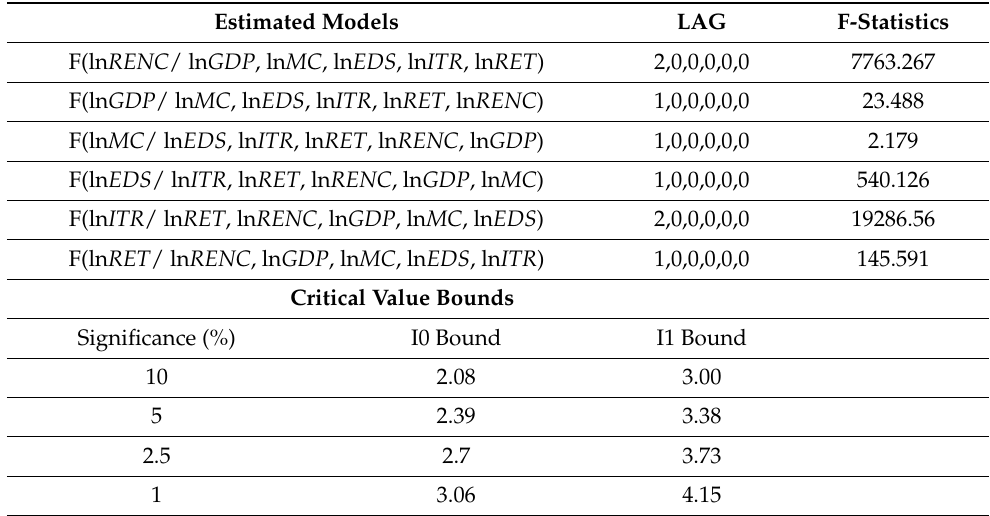
Table 5. ARDL Long Run Form and Bounds Test.